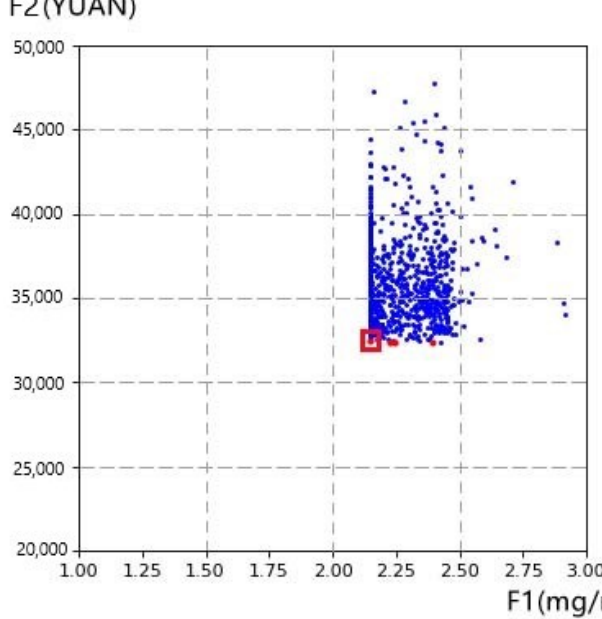
Figure 4. Pareto front for the proposed two objective functions.